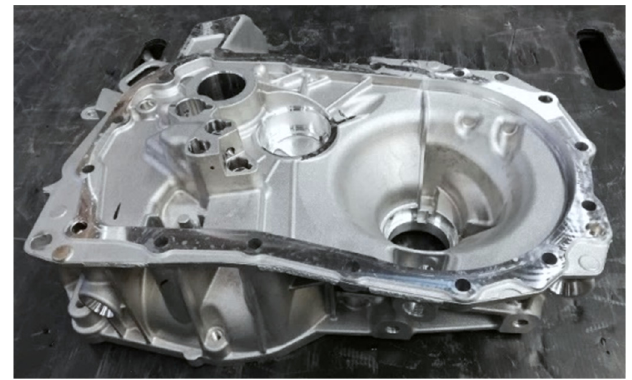
Figure 4. Crankcase mechanism.